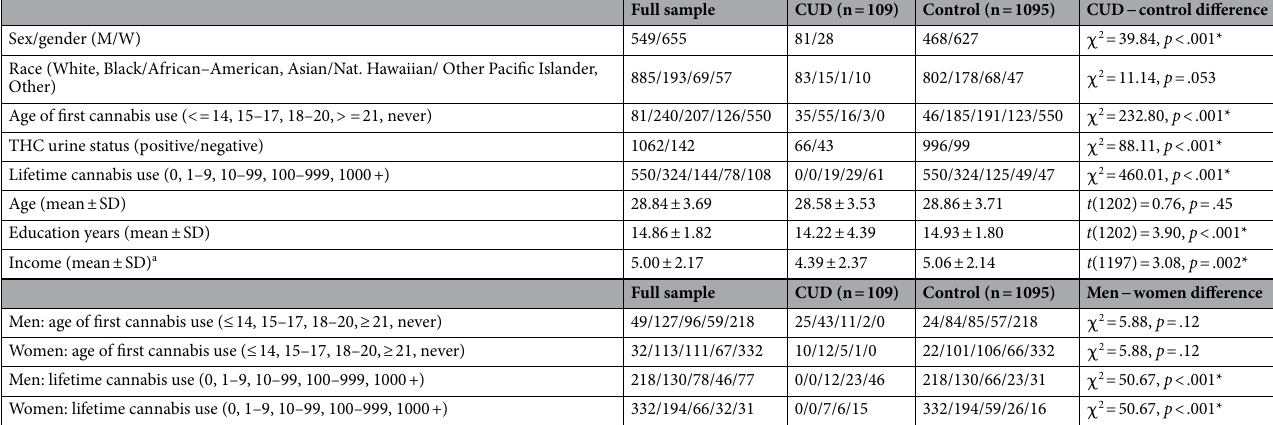
Table 1. Demographic characteristics of the full sample who completed the SSAGA interview (n = 1204). *Significant CUD-Control Difference or Men-Women Difference. a Income was binned (1 = < 10 k, 2 =